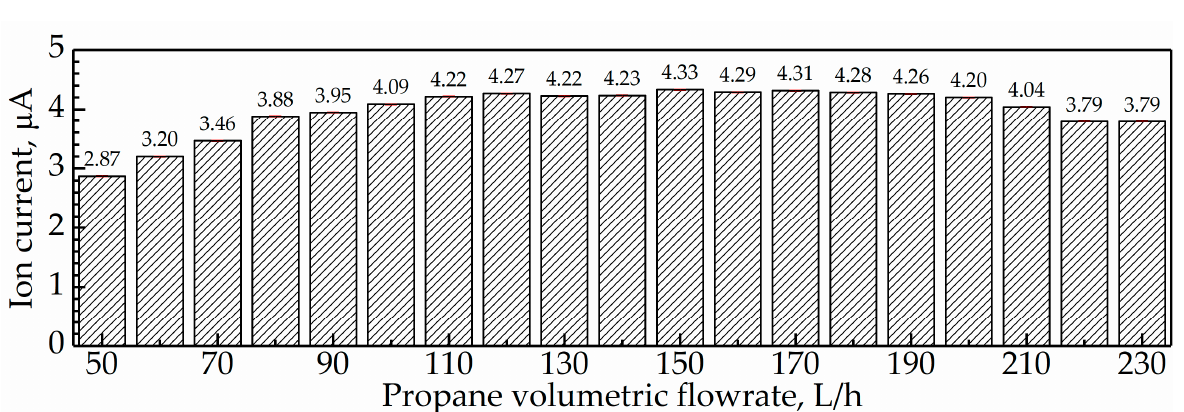
Figure 18. Average ion current during combustion at